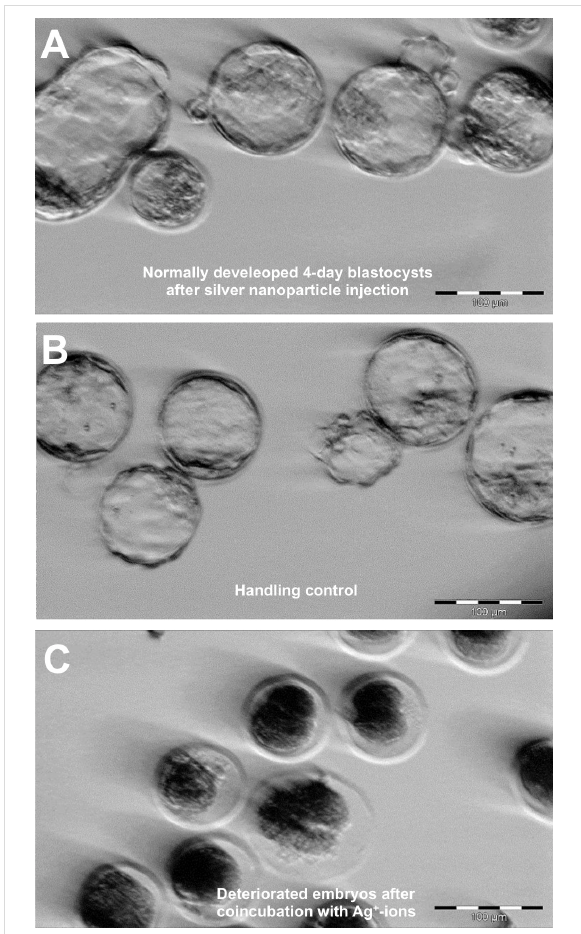
Figure 3: Representative stereo microscope images of murine blasto- cysts (A) after silver nanoparticle-injection (10 pL of a 50 µg/mL nanoparticle dispersion, equal to 3300 nanoparticles/embryo, mean primary particle diameter as determined by TEM: 21 nm), (B) untreated handling control, (C) deteriorated 2-cell-stage embryos after co-incuba- tion with silver ions (25 µM AgNO 3